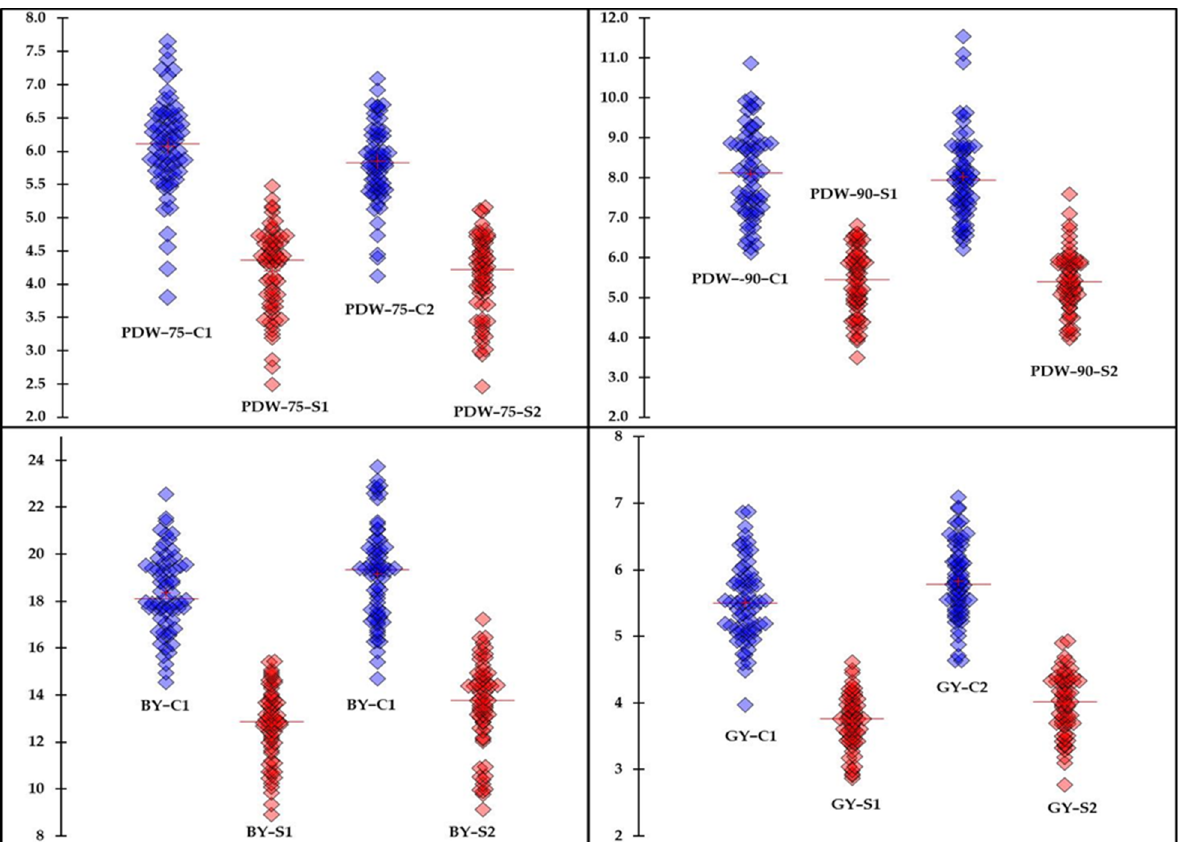
Figure 2. Box plots showing the variability for plant dry weight measured at 75 (PDW ‐ 75) and 90 (PDW ‐ 90) days after sowing, biological yield (BY), and grain yield (GY) of 64 wheat genotypes under the control (C) and salinity (S) conditions for the first year (Y1) and second year (Y2). Similar to the four traits, the mean values of different STIs also varied significantly among the 64 genotypes (Table 4). The maximum values of the YSI, YI, MRPI, MPI, GMPI, stress ‐ weighted performance index (SWPI), and harmonic mean productivity index (HMPI) were about two times higher than those of the minimum values, while the maximum values of the STI, REI, SSI, TOL, and relative salinity effect (RSE), were about 2 to 4 times higher than those of the minimum values (Table 4). Table 4. Destructive statistics ((minimum (Min), maximum (Max), range, mean values, and varia ‐ tion between Max and Min values (Var.)) of the different stress tolerance indices (STIs) calculated based on plant dry weight measured at 75 (PDW ‐ 75) and 90 (PDW ‐ 90) days after sowing, biological yield (BY), and grain yield (GY) of 64 wheat genotypes. Data are the average of two years and three replications ( n = 6). Source